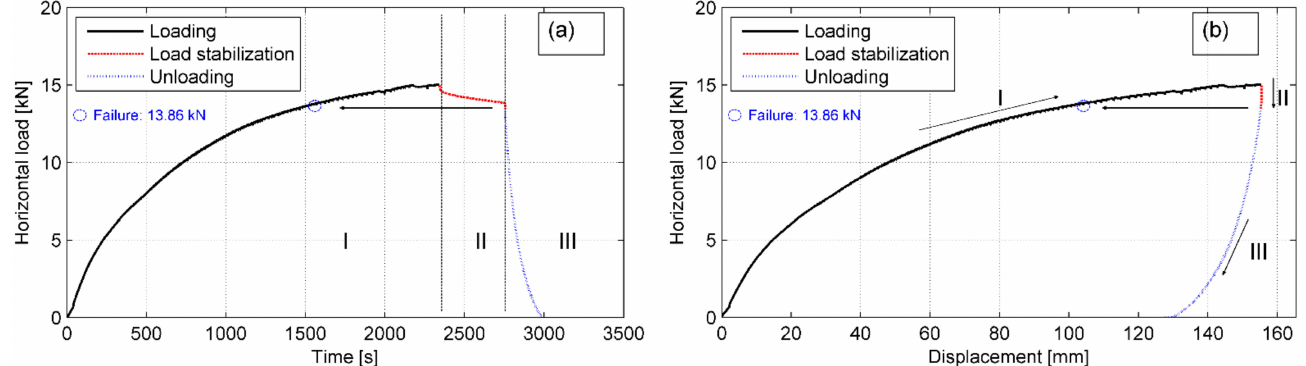
Figure 20. Typical curves for P-2 specimen in stage IV: ( a ) load–time curve; ( b ) load-displacement curve for average front displacement.